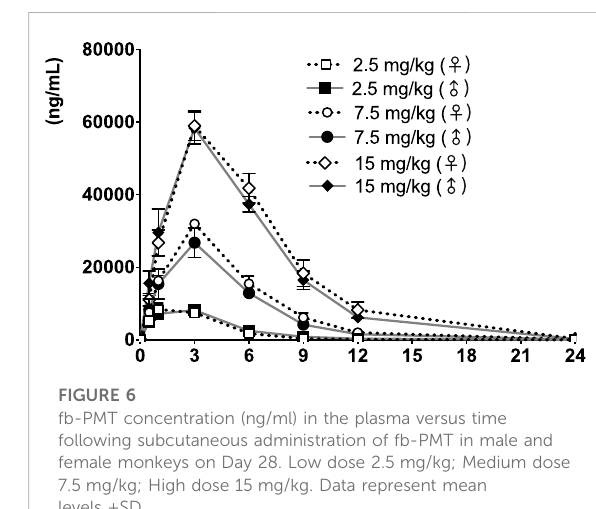
FIGURE 6 fb-PMT concentration (ng/ml) in the plasma versus time following subcutaneous administration of fb-PMT in male and female monkeys on Day 28. Low dose 2.5 mg/kg; Medium dose 7.5 mg/kg; High dose 15 mg/kg. Data represent mean levels ±SD.